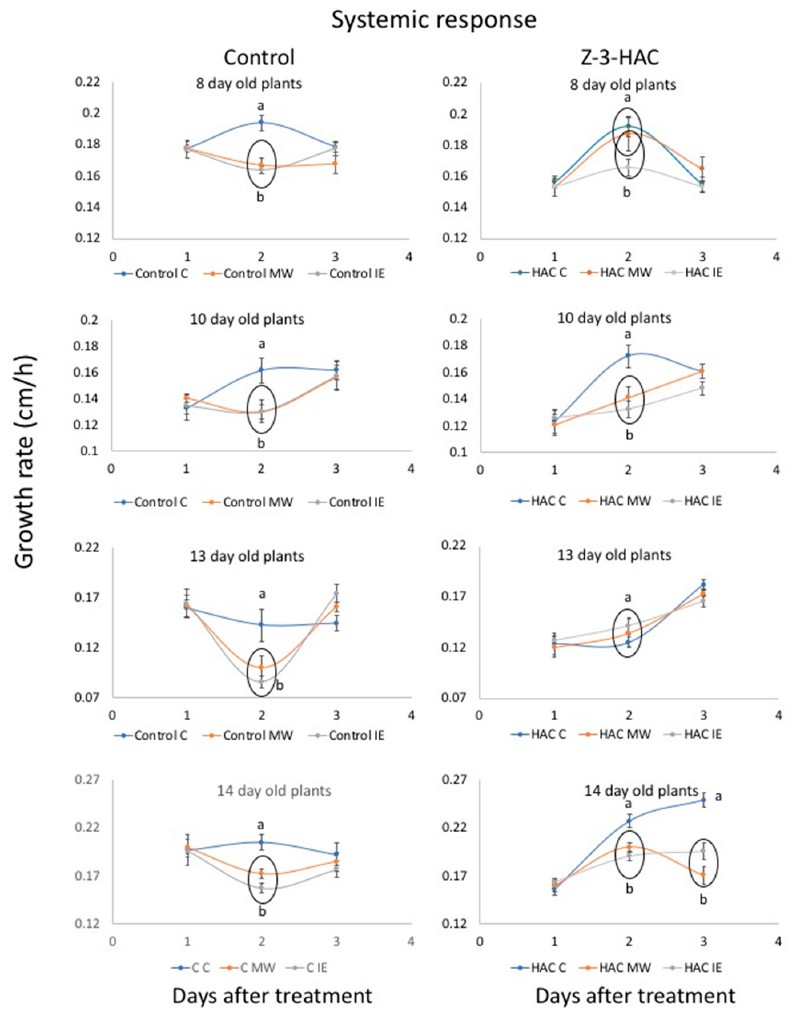
Figure 3. The effects of priming by ( Z )-3-hexen-1-yl acetate (Z-3-HAC) on mechanical wounding (MW) and insect elicitor (IE) induced growth responses in systemic leaves of maize ( Zea mays ) seedlings (expressed as growth rate in cm*h − 1 , n ≥ 7). Responses in control maize plants at different ages are shown in the left column and responses of Z-3-HAC-treated plants are shown in the right column. Maize seedlings were first exposed to physiological concentrations of Z-3-HAC (2 μ g l − 1 air volume) for 15 h before the MW or IE treatment was applied to an actively growing leaf (7- and 12-day-old seedlings) or a fully developed leaf (8- and 14-day-old seedlings). The growth of the next (systemic) leaf was measured for 3 days and is expressed as growth rate (cm*h − 1 ). Values are means ± SE and different letters indicate significant differences between the different treatments ( ANOVA , P < 0.05). Circled time points indicate no significant differences between treatments. Day 1 and Day 3 growth rates show no significant differences between treatments, with only 13-day-old Z-3-HAC-treated seedlings showing different growth rates on day 3.